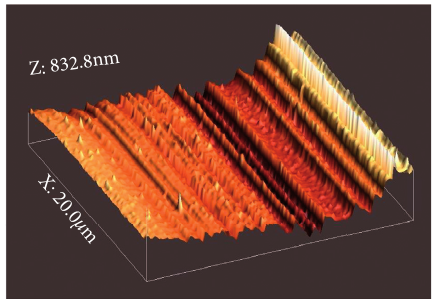
Figure 5: V 2 O 5 AFM image at room